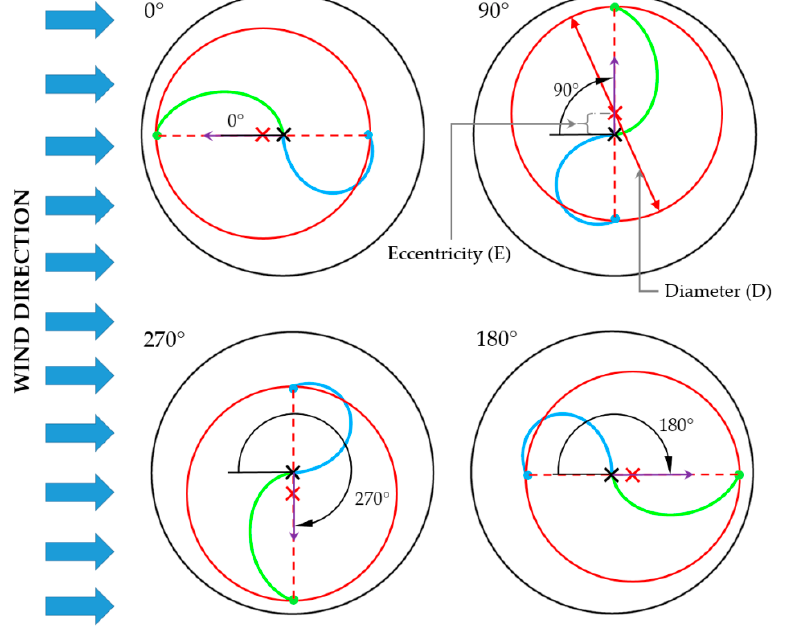
Figure 6. Angular positions of the eccentricity line.